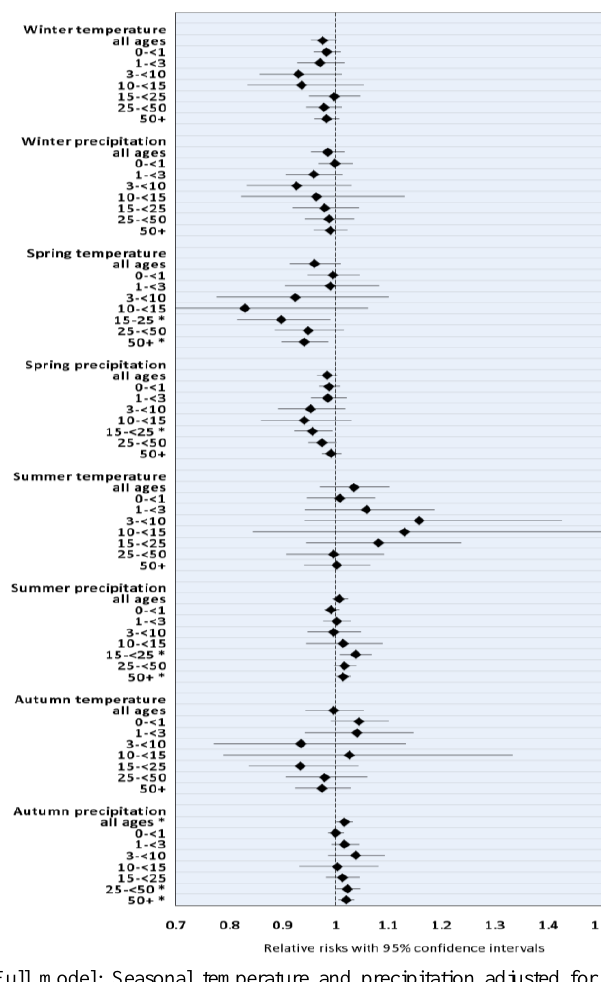
Figure 5. Association between seasonal climate variability and annual age-stratified mortality, Skellefteå